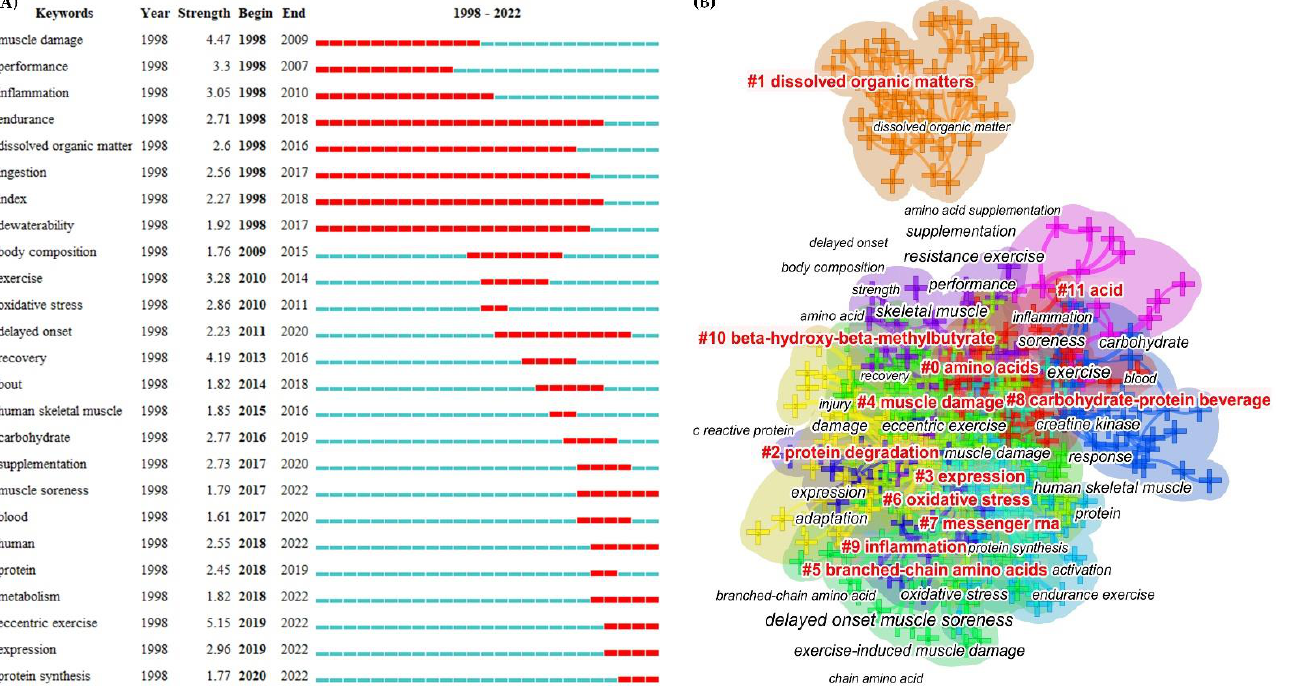
#5 branched-chain amino acids, #8 carbohydrate–protein beverage, #10 beta-hydroxy-beta- methylbutyrate, and #11 acid) and proposed mechanisms (#4 muscle damage, #3 expression, #6 oxidative stress, #7 messenger RNA, and #9